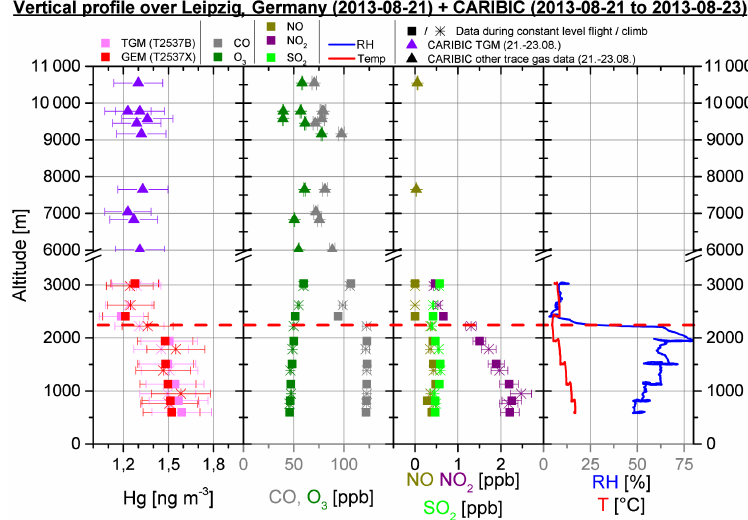
Figure 5. Vertical profile, measured within the ETMEP-2 campaign on 21 August 2013 from 13:15:00 to 14:07:30 (local time) over the city centre of Leipzig, Germany (51.353 ◦ N, 12.434 ◦ E, elevation: 125m, flat terrain) and from 21 to 23 August 2013 over western Europe (east of 0 ◦ W; CARIBIC). While the ETMEP-2 data were averaged for 300s (squares) and 150s (stars), the CARIBIC data (triangles) represent 600s averages. The plots have the same structure as Fig. 3. The PBL top (red dashed line) was determined to be at 2200 to 2250ma.s.l. Please note that the y axis is broken between 3500 and 6000m. TGM and GEM concentrations form ETMEP-2 and CARIBIC measurements are given at standard temperature and pressure ( T = 273.15K, p =